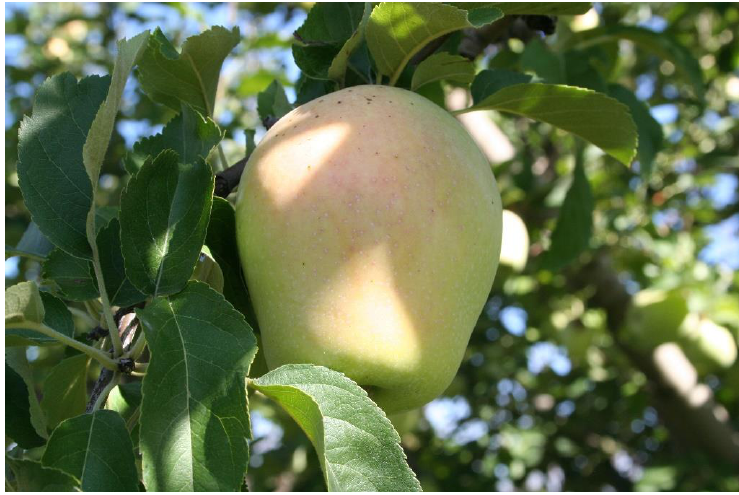
Figure 1. Fruit of “Pero de Cehegín”.